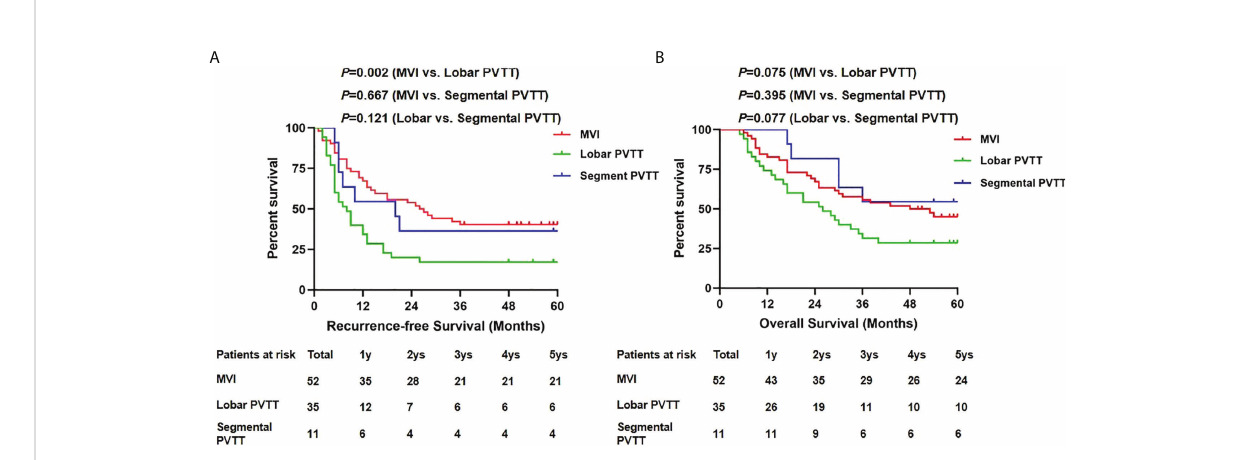
FIGURE 4 Recurrence-free survivals (A) and overall survivals (B) comparison among MVI, lobar and segmental PVTT